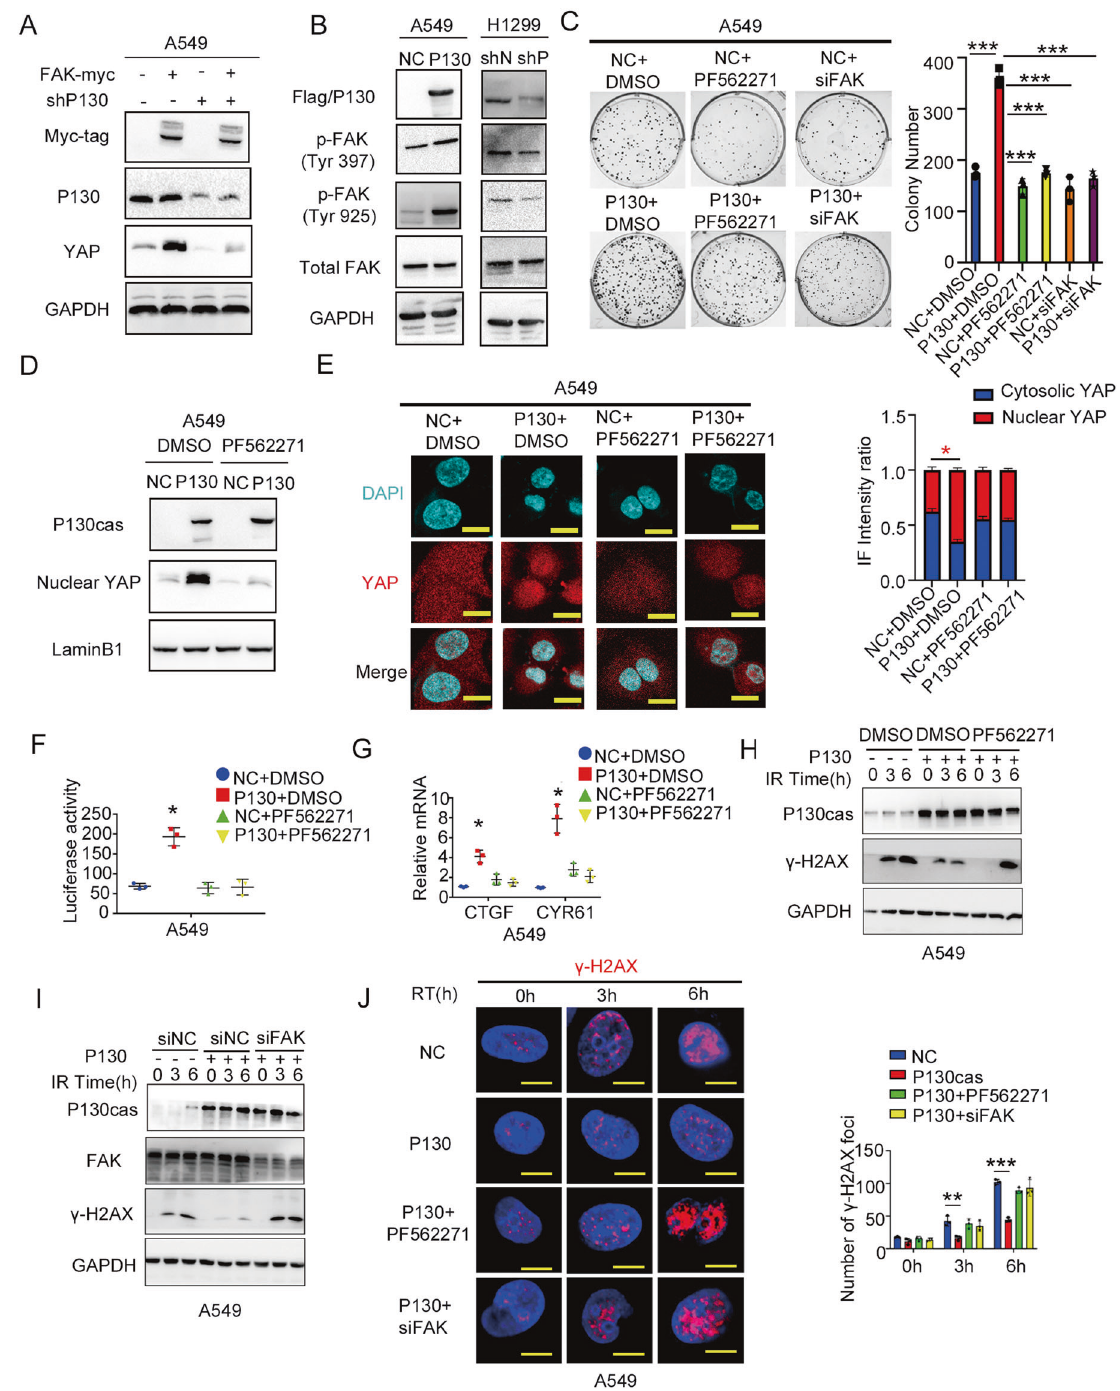
Fig. 4 P130cas stabilizes YAP by activating FAK signaling. A Immunoblotting of Myc-tag, P130cas (P130), YAP and GAPDH in H1299 cells transfected with FAK-myc alone or in combination with P130cas shRNA. B Immunoblotting of Flag/P130cas (P130), FAK-Tyr397, FAK-Tyr925, total FAK and GAPDH in A549 cells overexpressing P130cas or in H1299 cells transfected with P130cas shRNA. C Representative images and data quanti fi cation of colony formation by A549 cells overexpressing P130cas alone versus in combination with PF562271 or FAK siRNA. ** P < 0.01. In A549 cells overexpressing P130cas alone or in combination with PF562271, after nucleoplasmic separation, using immunoblotting to evaluate P130cas, nuclear YAP and LaminB1 ( D ), using immuno fl uorescence to evaluate YAP subcellular distribution ( E ), using luciferase reporter assay ( F ) and qPCR assay ( G ) to detect the downstream gene activity of YAP ( t test. * P < 0.05). In A549 cells overexpressing P130cas alone or in combination with PF562271/FAK-siRNA, immunoblotting of P130cas, γ -H2AX and GAPDH at the indicated time points after 5 Gy ionizing radiation ( H , I ), representative immuno fl uorescence images of the number of γ -H2AX foci at the indicated time points after 5 Gy ionizing radiation ( J , scale bar = 10 μ m). Each experiment was quanti fi ed as Mean ± SD of three independent experiments ( t -test, two-sided, * P < 0.05, ** P < 0.01, *** P < 0.001). For Western blot experiments, the samples derive from the same experiment and the gels/ blots were processed in